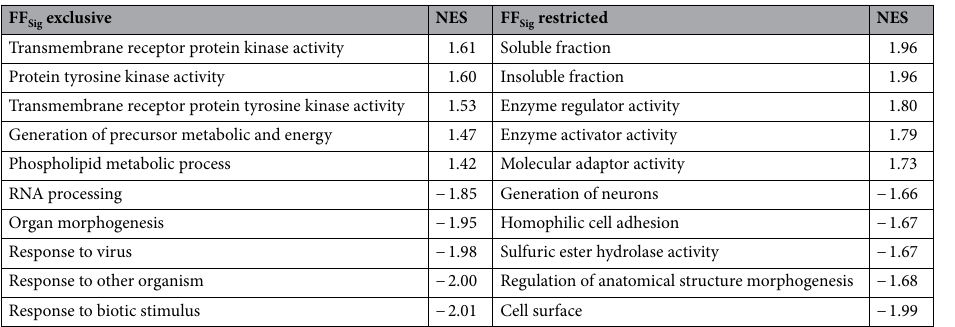
Table 4. The GO terms that have the highest NES and exclusively RRs with FF Sig (left) and the GO terms that are restricted to have RRs with FF Sig (right), experimented on the NRG-H dataset.